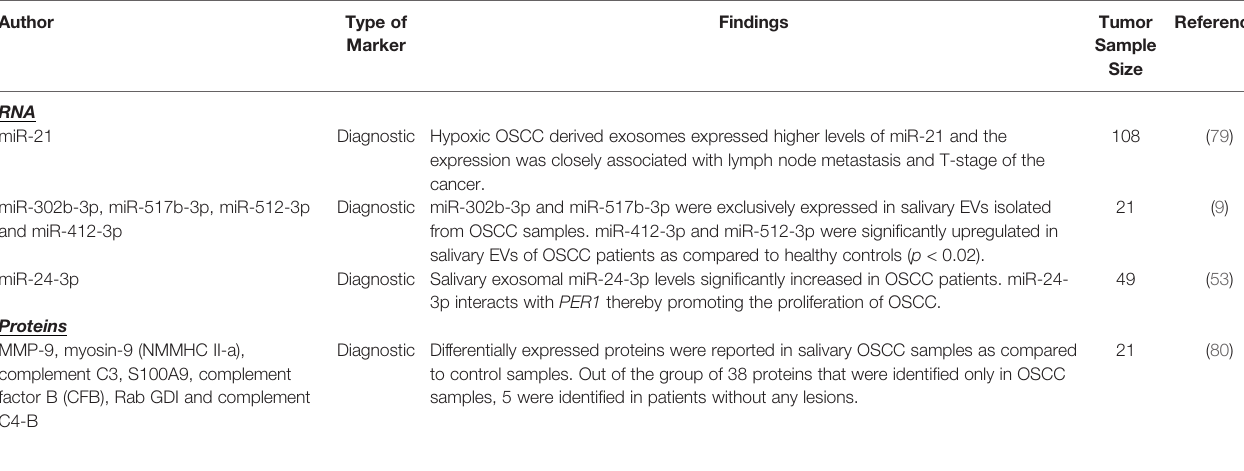
TABLE 3 | Exosomal biomarkers for